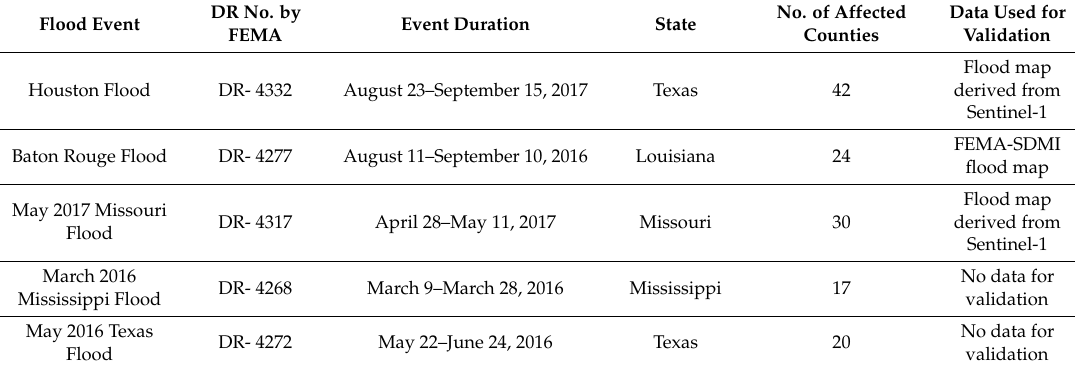
Table 1. Summary description of five selected case